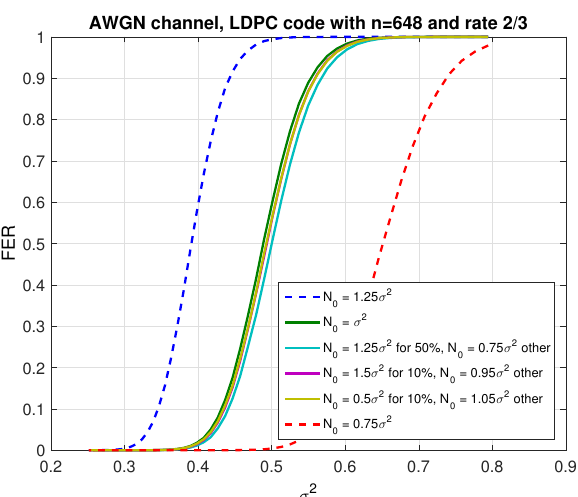
Figure 4. Decoding failure probability for a signal with E b = 1 and variable noise variance. The four solid curves, which correspond to combinations with the same SNR eff , are nearly